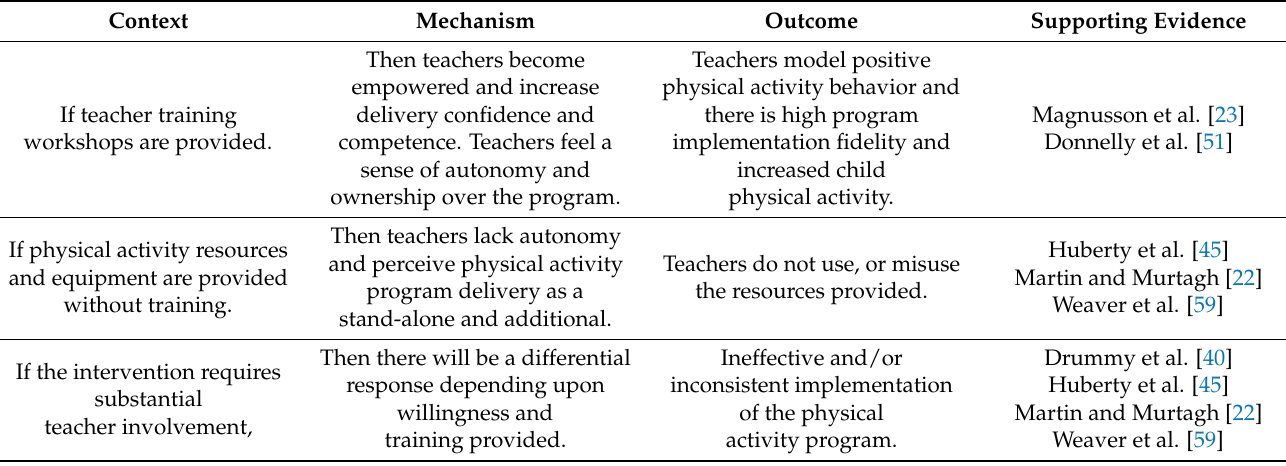
Table 2. Interpersonal level (class teacher) of a conceptual framework for School-Based Physical Activity Interventions in Children Aged 7–11 Years of program theories (context-mechanism-outcome).